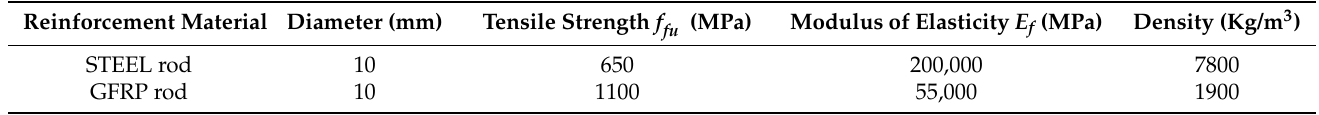
Table 3. Mechanical properties of steel and GFRP